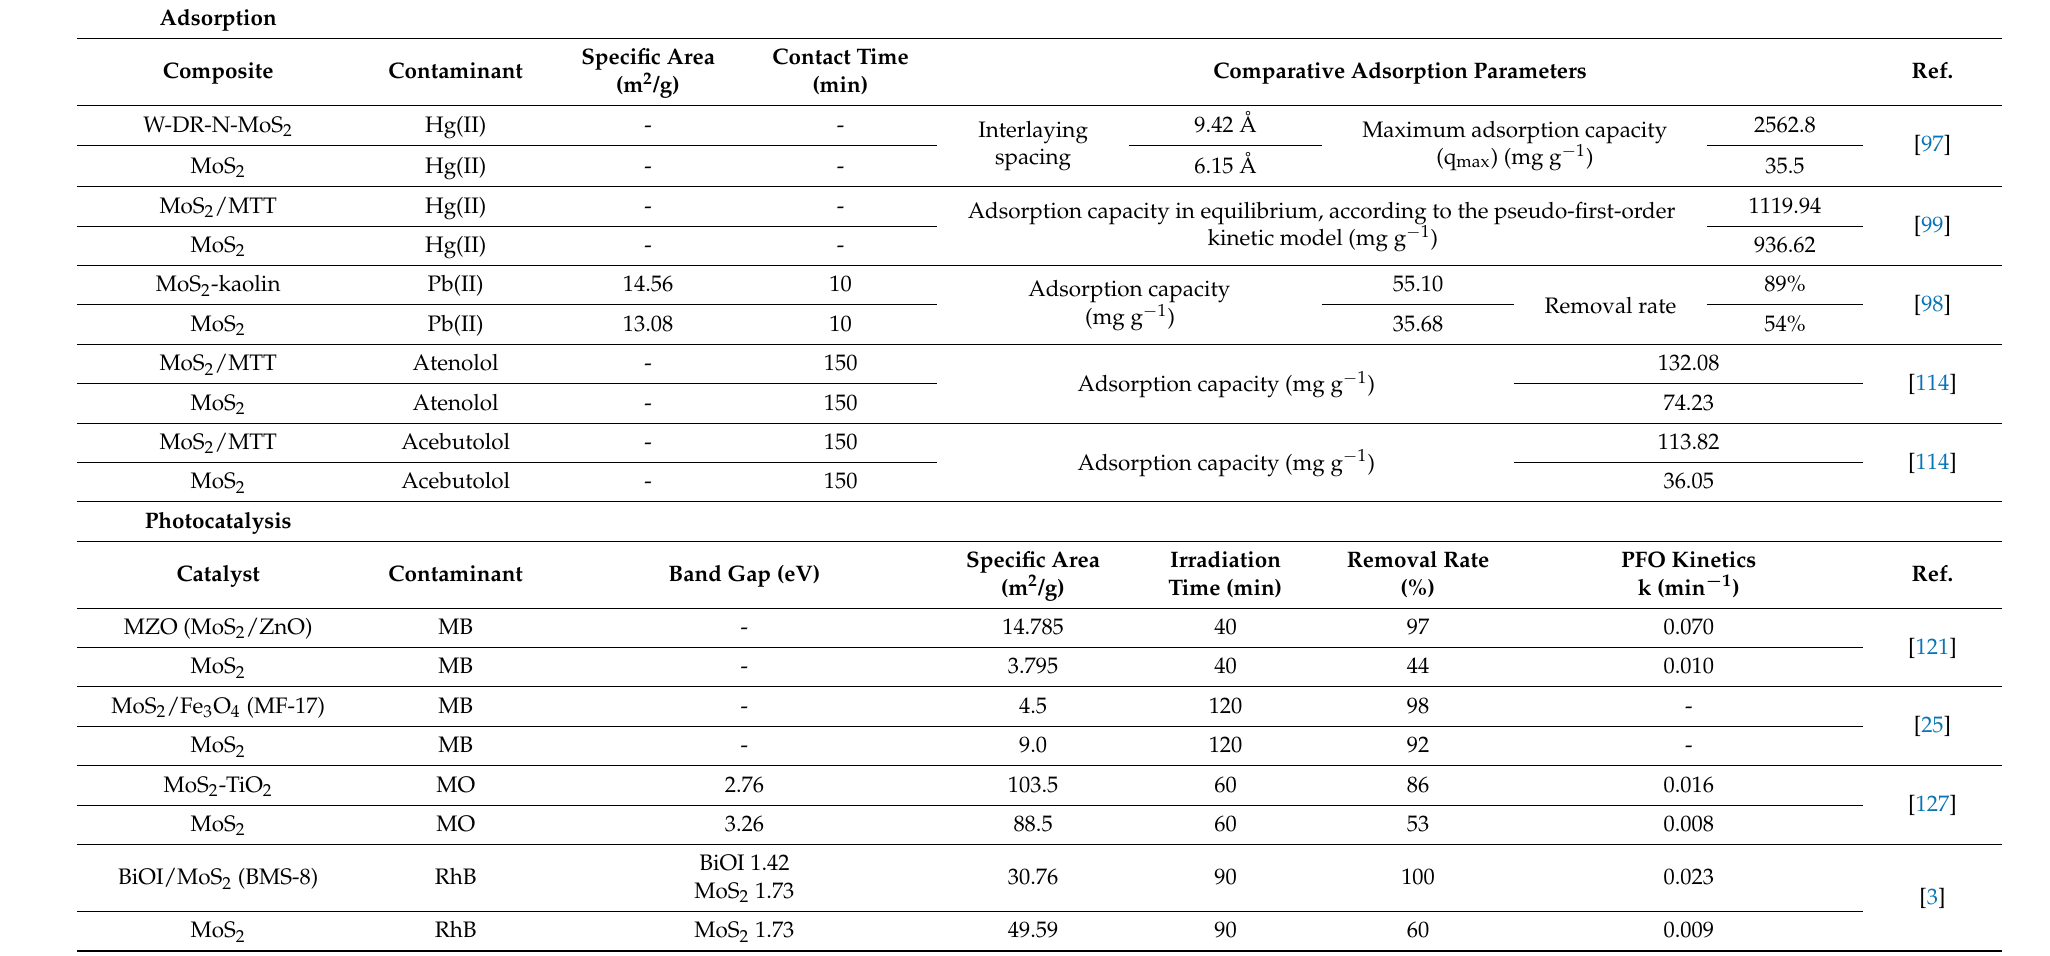
Table 4. Adsorption and photocatalytic performance of MoS 2 -based nanocomposites and a comparison with bare MoS 2